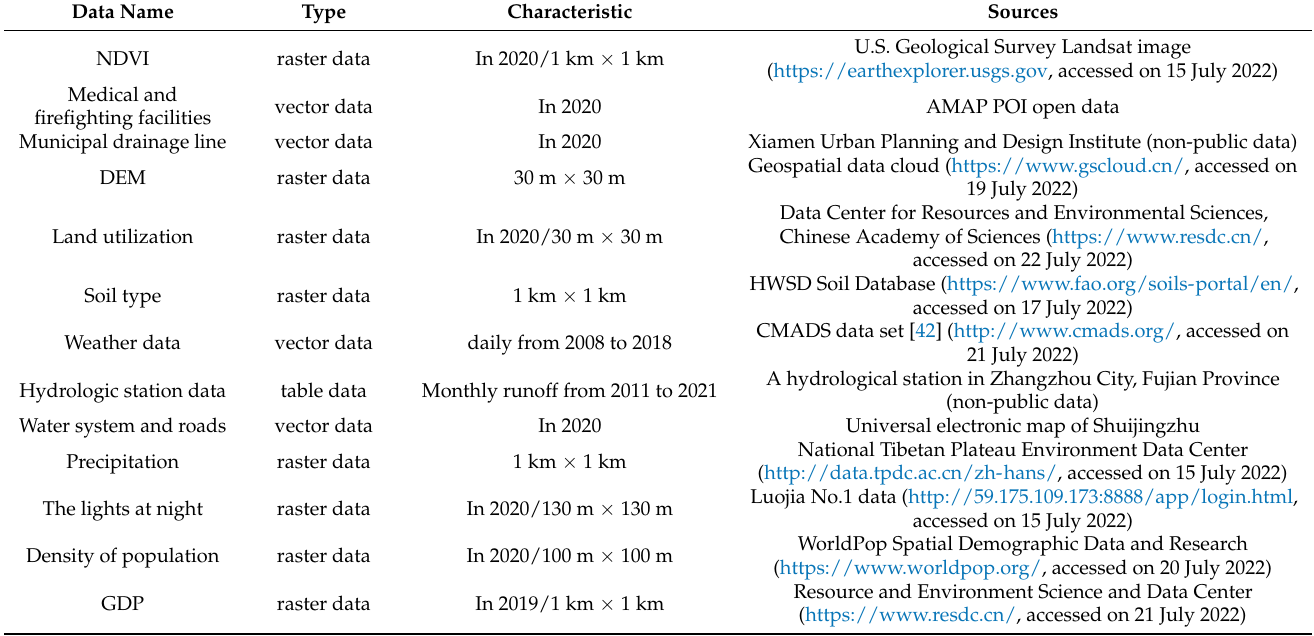
Table 1. Main data characteristics and